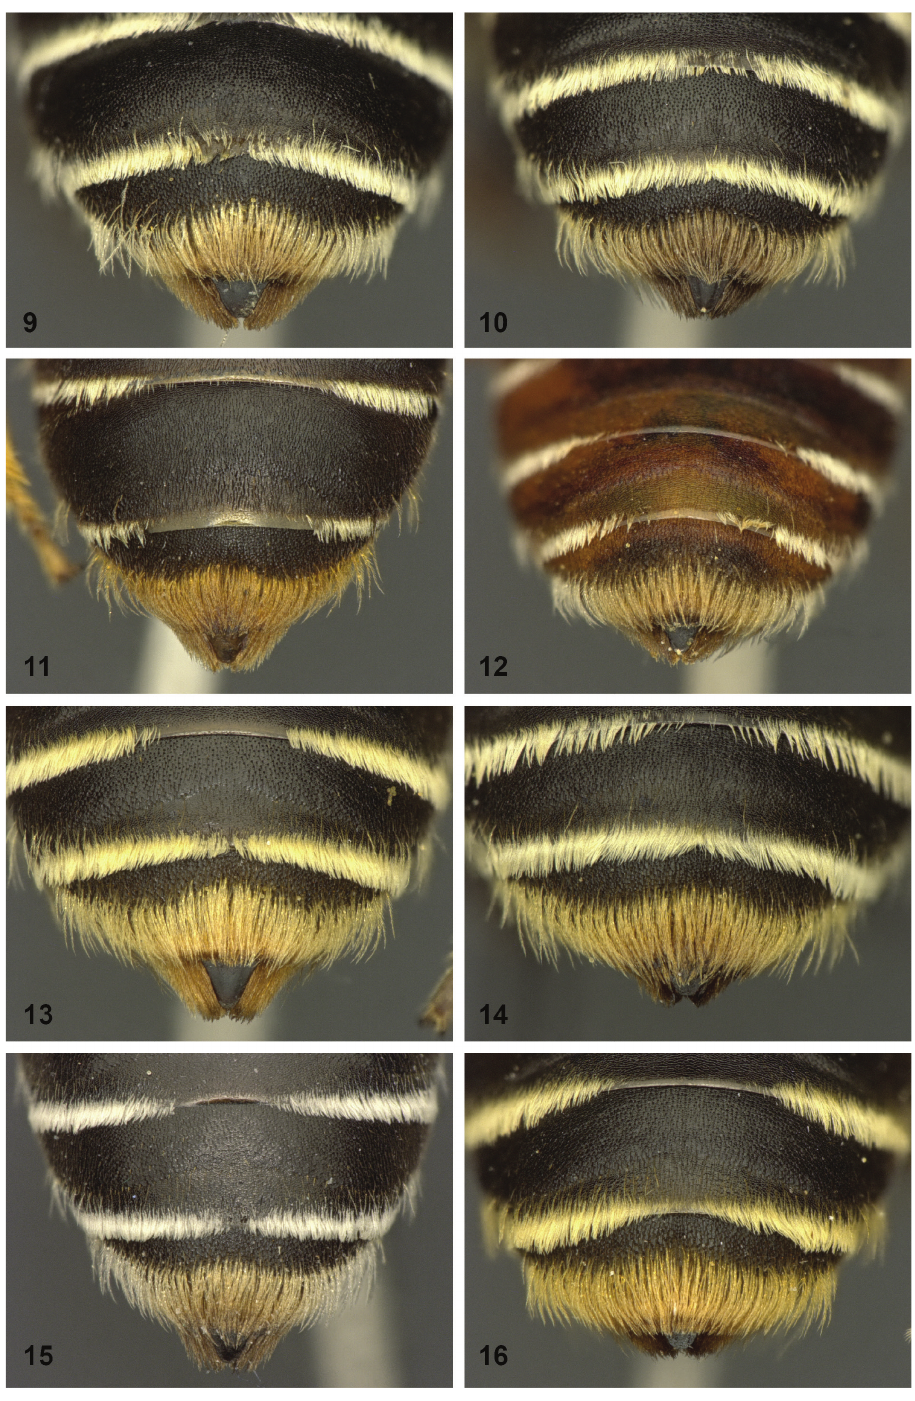
Figures 9–16. Terminal fringes of females of Taeniandrena 9 Andrena afzeliella 10 A. ovatula 11 A. antonellae sp. nov. 12 A. croceiventris 13 A. gelriae 14 A. intermedia 15 A. ovata 16 A. russula